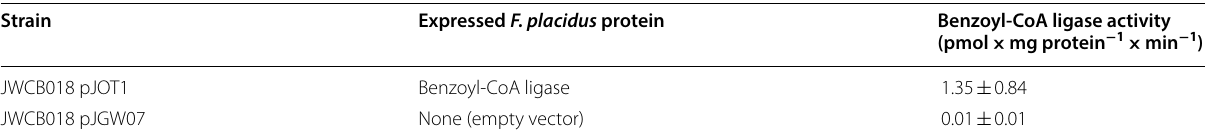
Table 1 Benzoyl-CoA ligase activity in clarified cell extract of a C. bescii strain heterologously expressing a benzoyl-CoA ligase from Ferroglobus placidus grown at 65 °C